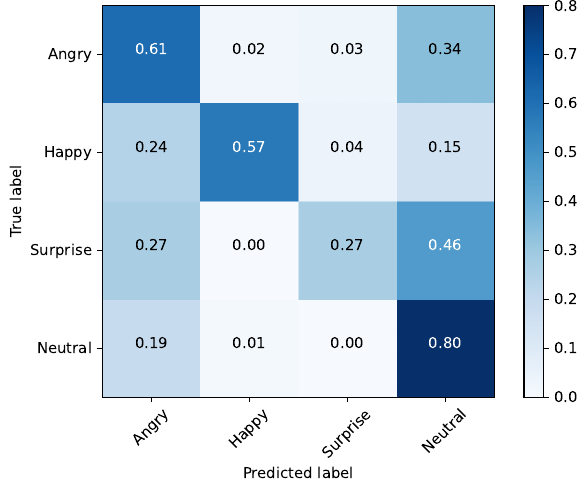
Figure 10. Testing set (SFEW) and the top-4 performing